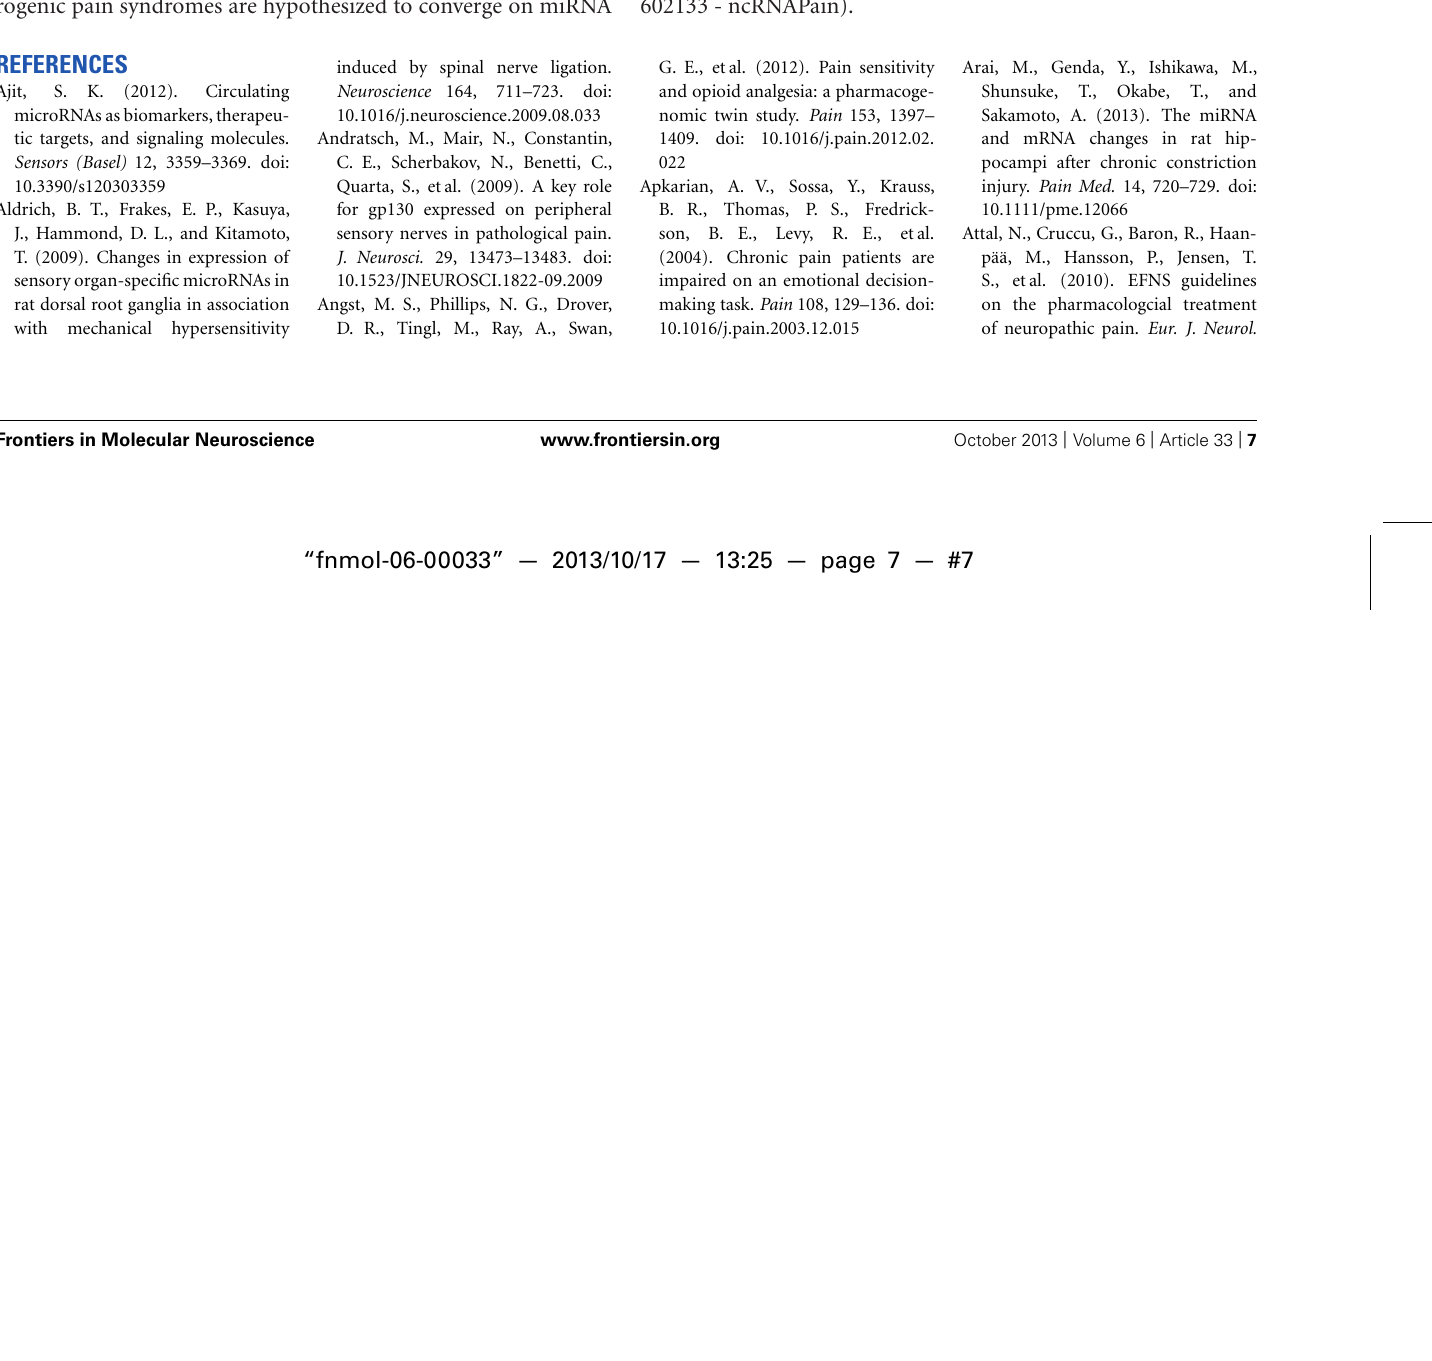
FIGURE 3 | Endogenous miRNAs are generated from primary (pri-) miRNAs via cleavage by the RNAse Drosha into pre-miRNAs in the nucleus. They are exported into the cytosol by Exportin 5 and there are cleaved into active miRNAs by the RNAse Dicer. Depending on the degree of homology, miRNAs trigger translational repression or degradation of target mRNAs (for review see He and Hannon, 2004; Bartel, 2009). Therapeutic manipulations of miRNAs may involve various methods. Host tissue miRNAs (gray) bind to complementary sequences, which are often located in the 3 (cid:3) -untranslated region (3 (cid:3) -UTR) of the target genes. This leads to translational repression, often accompanied by